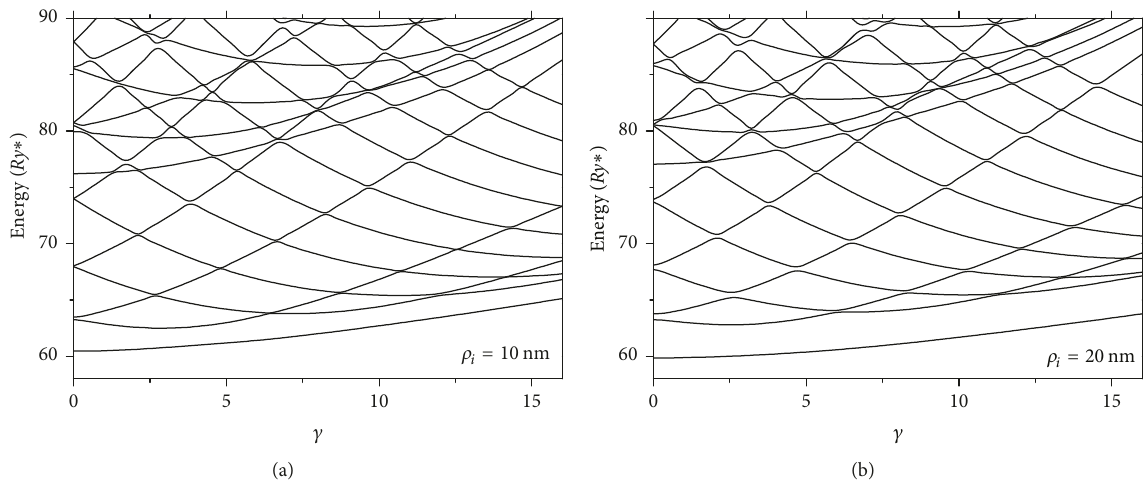
Figure 5: Energies of the off-center donor in circular QR as functions of the external magnetic field calculated for two different donor’s